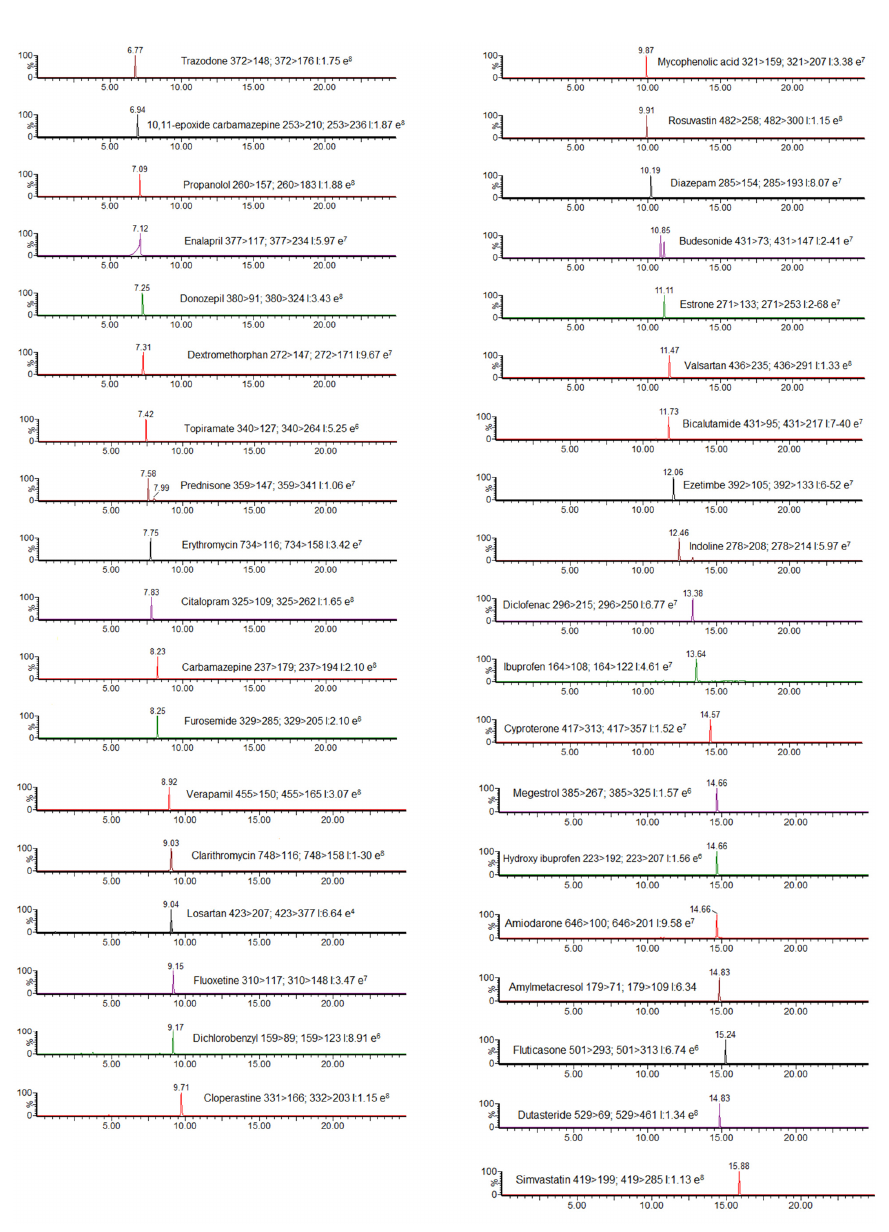
Figure 1. LC-MS/MS separation of the 76 pharmaceuticals, metabolites and transformation product (TP) with CORTECS T3 column. The compounds acetylsalicylic acid/salicylic acid, omeprazole/esomeprazole, citalopram/escitalopram and 1-hydroxy ibuprofen/2-hydroxy ibuprofen coeluted at the same retention times due to the same MS